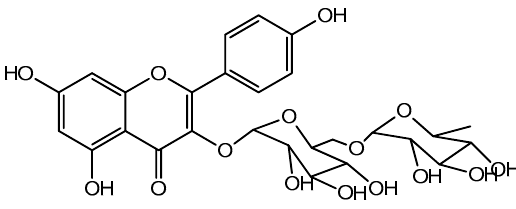
Figure 1. Chemical structure of nicotiflorin.